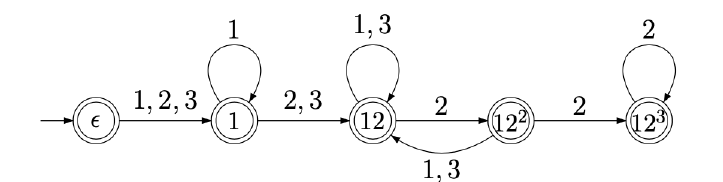
Figure 1: The directed graph G 3 , 2